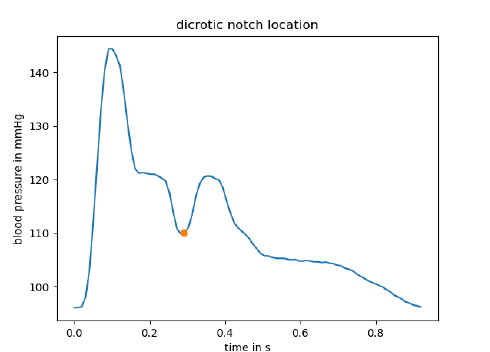
Figure 2. Example pressure pulse wave from the radial artery. Dicrotic notch location is marked with orange